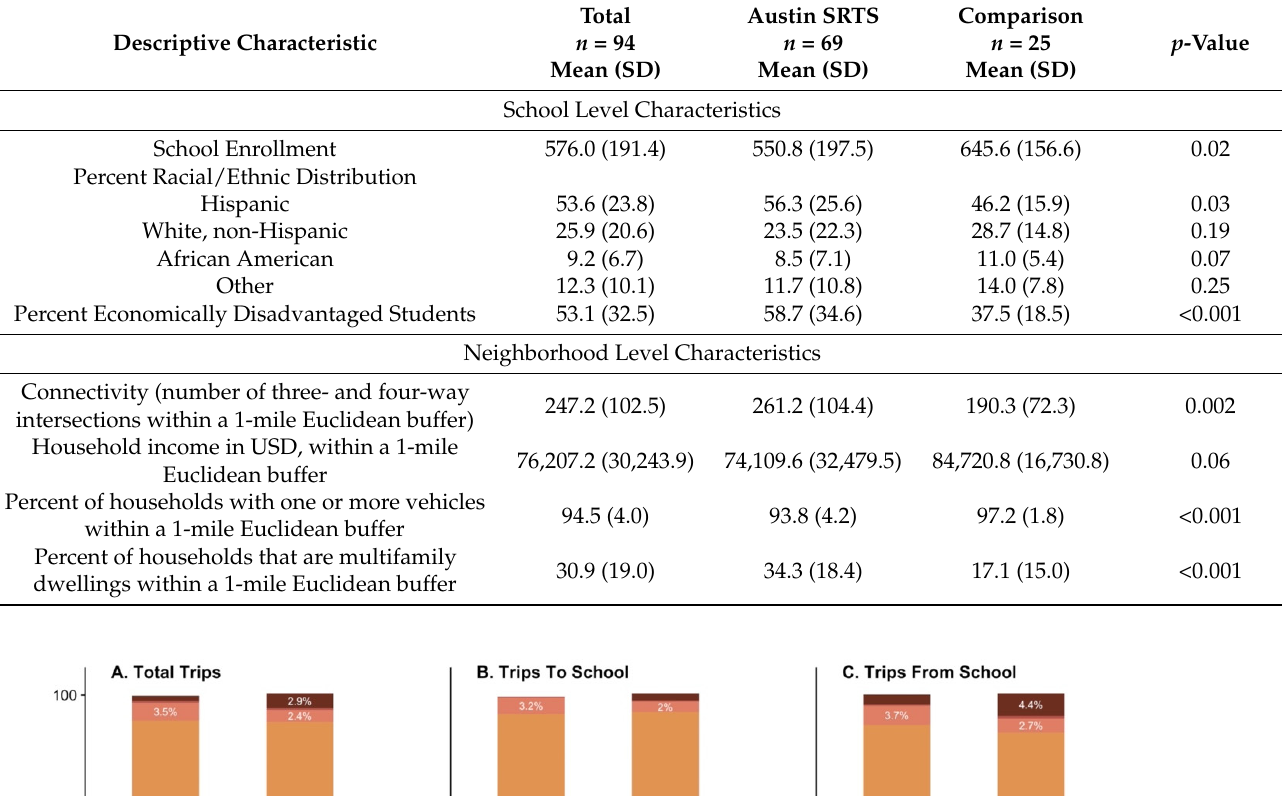
Table 2. Descriptive characteristics of the Safe TRavel Environment Evaluation in Texas Schools (STREETS) serial cross sectional study schools.